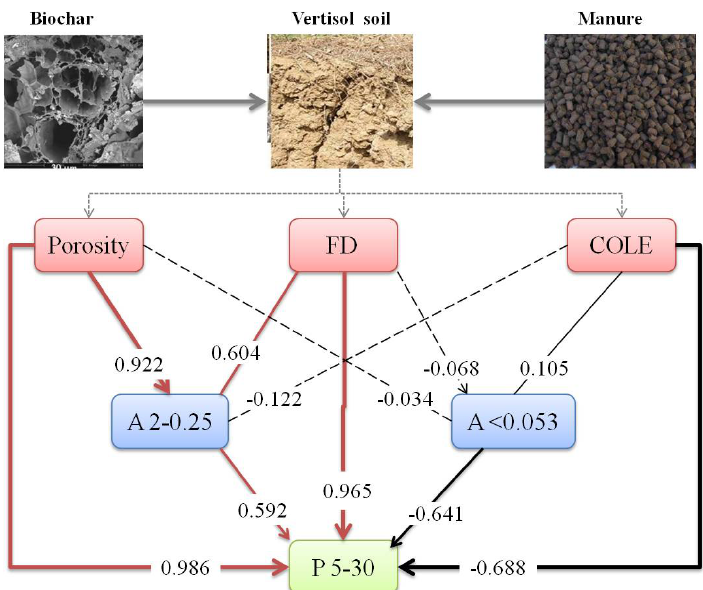
Figure 4. Structural equation modeling (SEM) analysis of the biochar and manure synergistic effects on micropore volume with equivalent pore diameter (5–30 μ m).